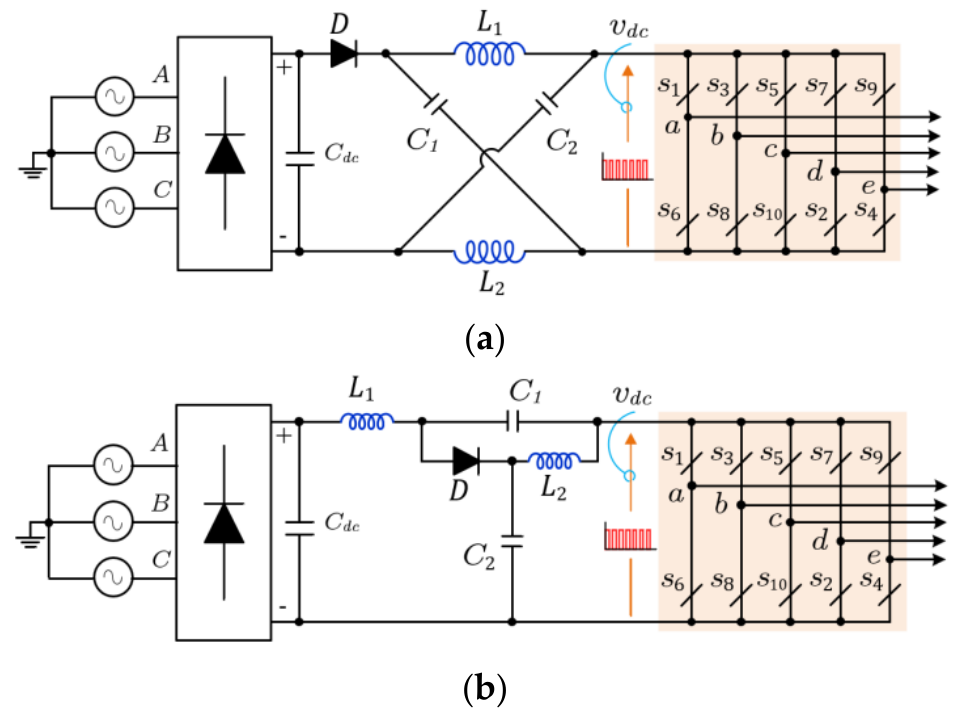
Figure 2. Z-source topologies for five-phase drives. ( a ) Basic five-phase Z-source inverter [7]. ( b ) Five-phase quasi-Z-source inverter [8].